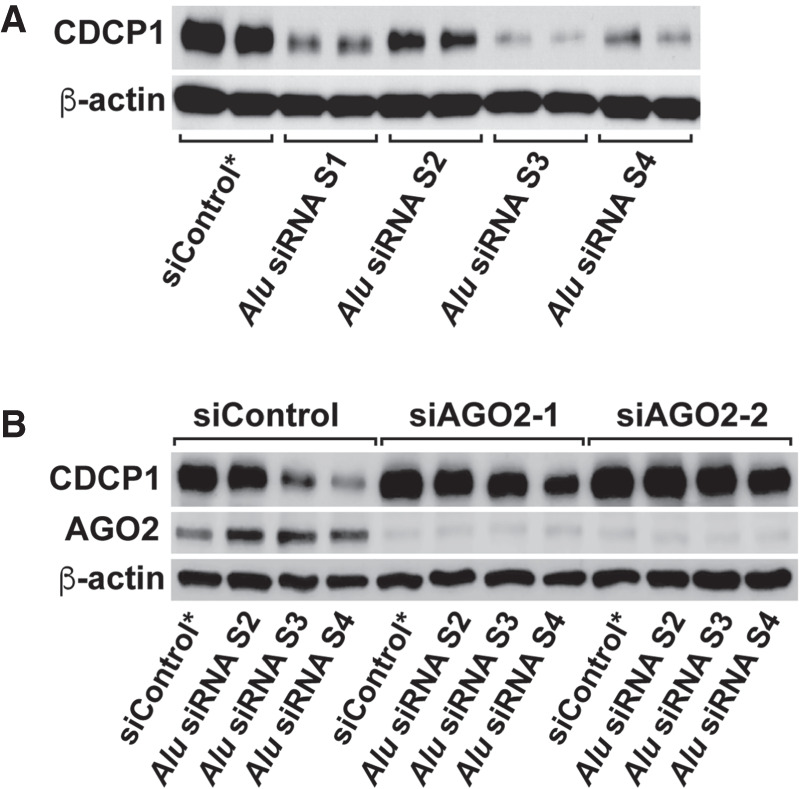
Alu siRNAs target CDCP1 in an AGO2-dependent manner. (A) Western blotting analysis of CDCP1 (full-length 135 kDa bands) in Alu siRNA-transfected HeLa cells at 72 h post-transfection. β-actin was used as a loading control. (B) The CDCP1 levels in Alu siRNA-transfected AGO2 knockdown cells were evaluated by western blotting. HeLa cells were treated with AGO2 siRNA twice. Alu siRNA and the second AGO2 siRNA were transfected into HeLa cells 48 h after the first AGO2 siRNA treatment.